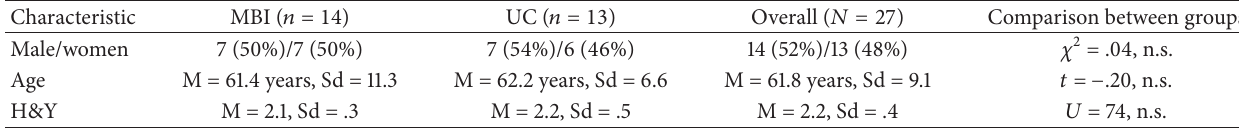
Table 1: Baseline demographic characteristics by intervention status.